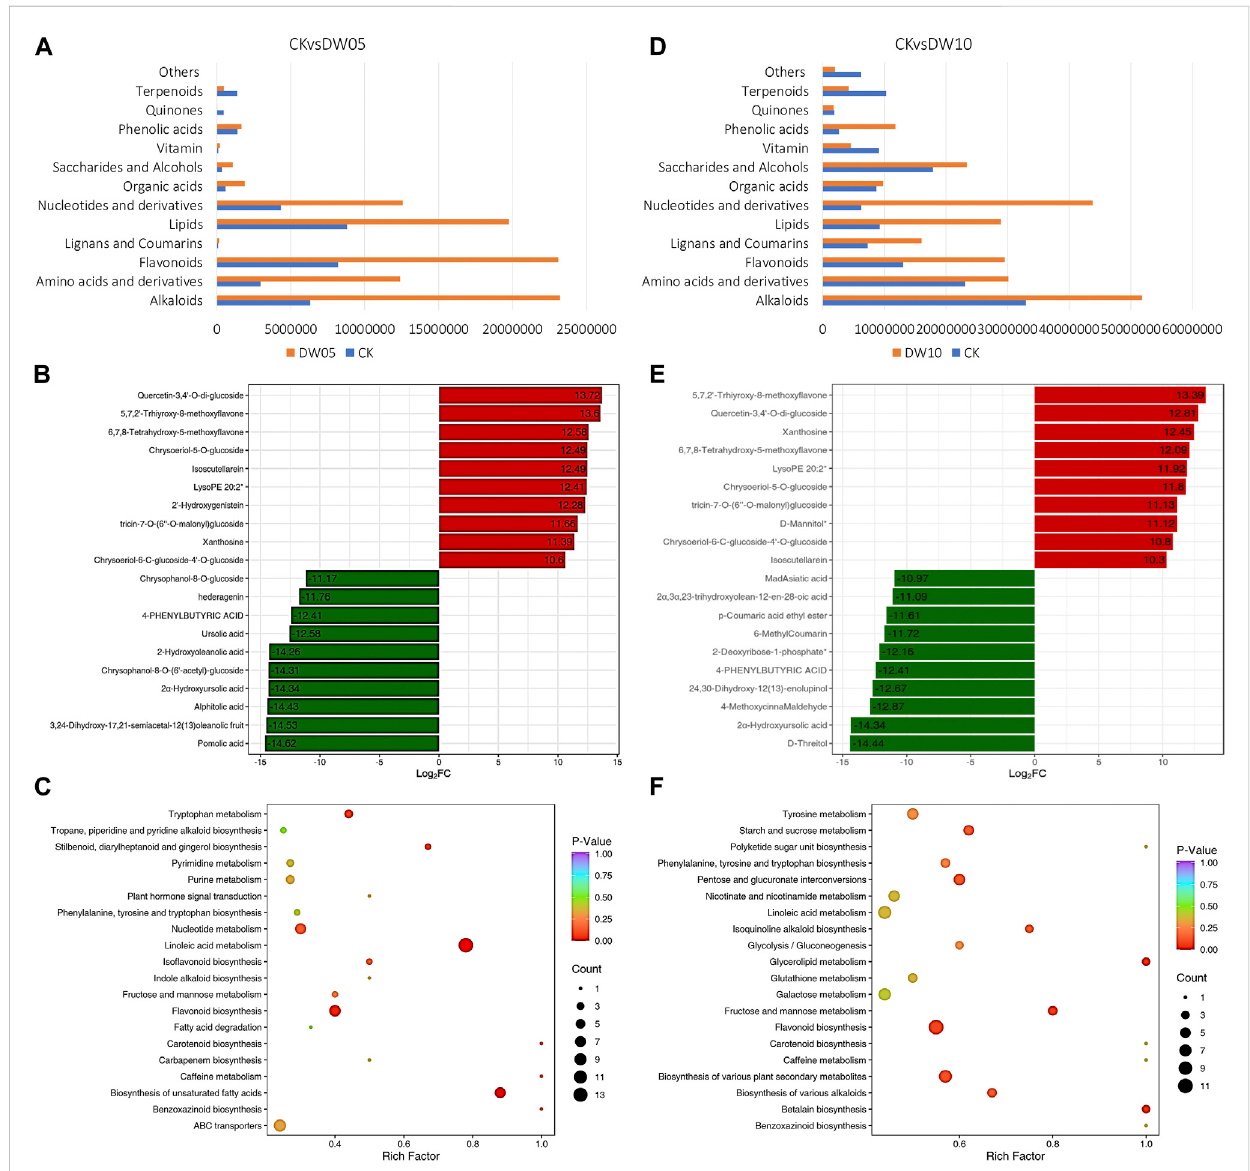
FIGURE 2 Half-waterlogging driven metabolomic changes in Adiantum leaves. (A) Changes in the accumulation pattern of major compound classes after 5 days of halfwaterlogging.Thebarsrepresentthesumoftherelativeintensitiesofcompoundsincludedineachclass. (B) topandbottom10accumulatedcompoundsin Adiantum leaves after 5 days of half waterlogging, and (C) scatter plot showing the pathways to which the DAMs were signi fi cantly enriched after 5 days of half waterlogging. (D) Changes in the accumulation pattern of major compound classes after 10 days of half waterlogging. The bars represent the sum of the relative intensities of compounds included in each class. (E) top and bottom 10 accumulated compounds in Adiantum leaves after 10 days of half waterlogging, and (F) scatter plot showing the pathways to which the DAMs were signi fi cantly enriched after 10 days of half